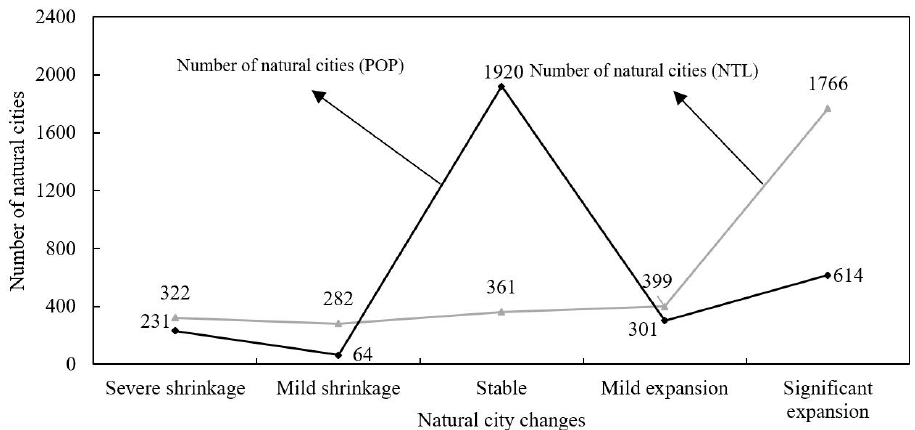
Figure 7. The relationship between urban shrinkage and expansion and the number of cities.